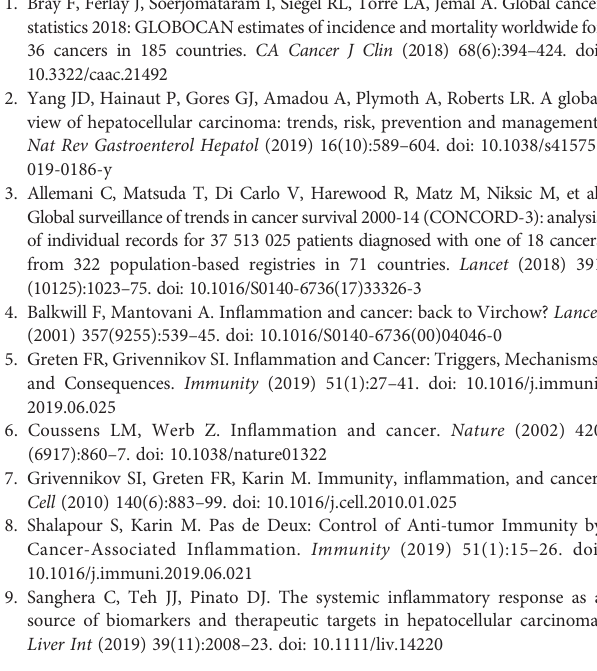
Supplementary Table 3 | The primer sequences of the eight prognostic genes. Supplementary Table 4 | The results of correlation analysis of the prognosis gene expression and chemotherapy drug sensitivity. Supplementary Table 5 | The information of primary antibodies used in IHC.